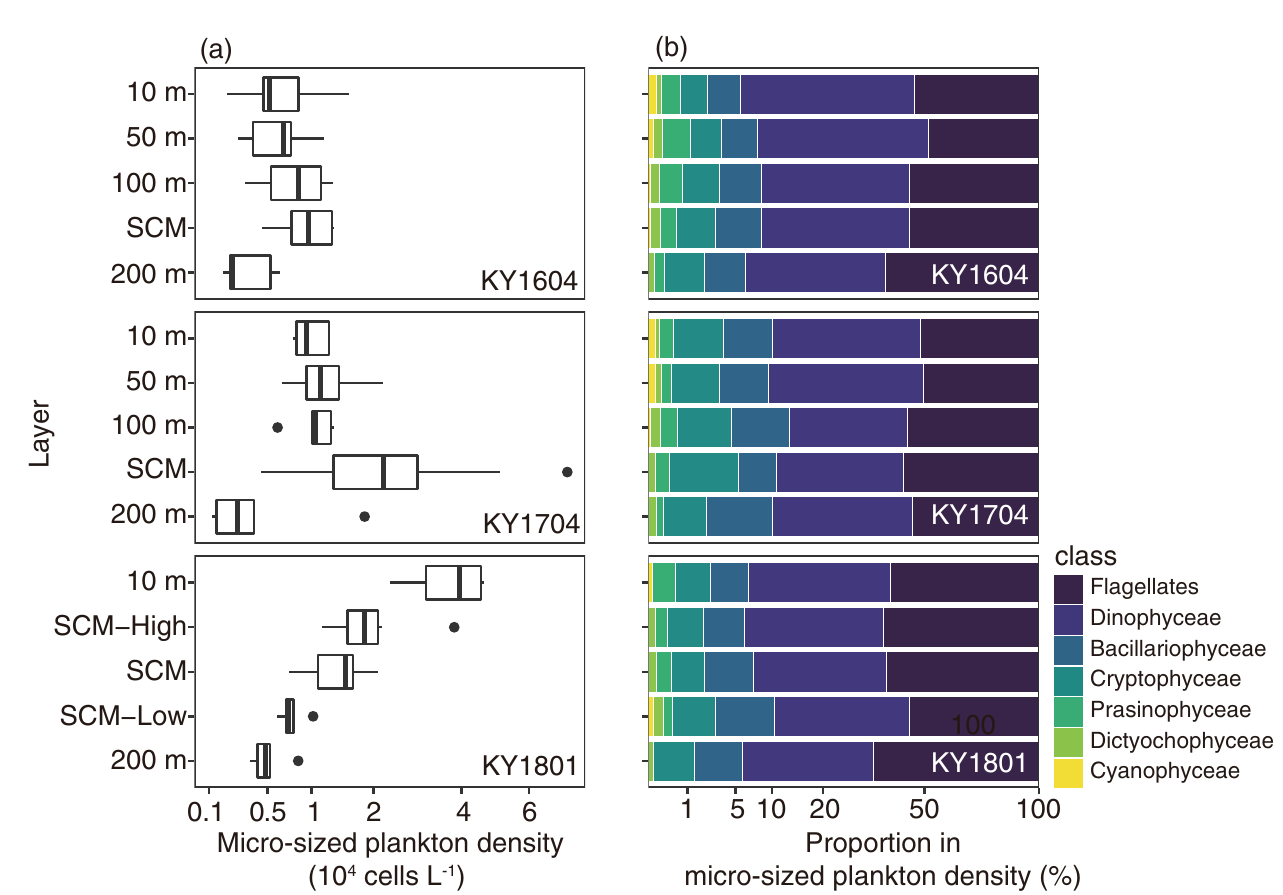
Fig 3. Vertical distribution of (a) micro-size plankton density (cells L -1 ) and (b) their mean community structure for KY1604 (top), KY1704 (middle), and KY1801 (bottom). Haptophyceae and Euglenophyceae are not present in the community structure panel. In the boxplots, the thick vertical line in each box represents the median values. Boxes indicate the lower and upper quartiles. Horizontal lines extending from each box represent the minimum and maximum values. The closed circles are the outliers. The x-axes are transformed square root